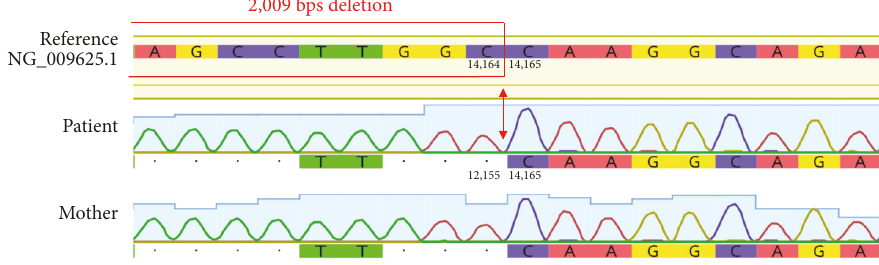
Figure 2: GenomicDNAsequenceelectropherograms of thepatientand hermother, in comparison with thereferencesequence.Thedeletion is 2,009 bps in size and encompasses exons 5 and 6. The red arrows locate the 3 󸀠 end breakpoint, whereas the red frame illustrates a part of the deleted sequence. The deletion boundaries are noted on the patient strand, as indicated by the nucleotide positions.